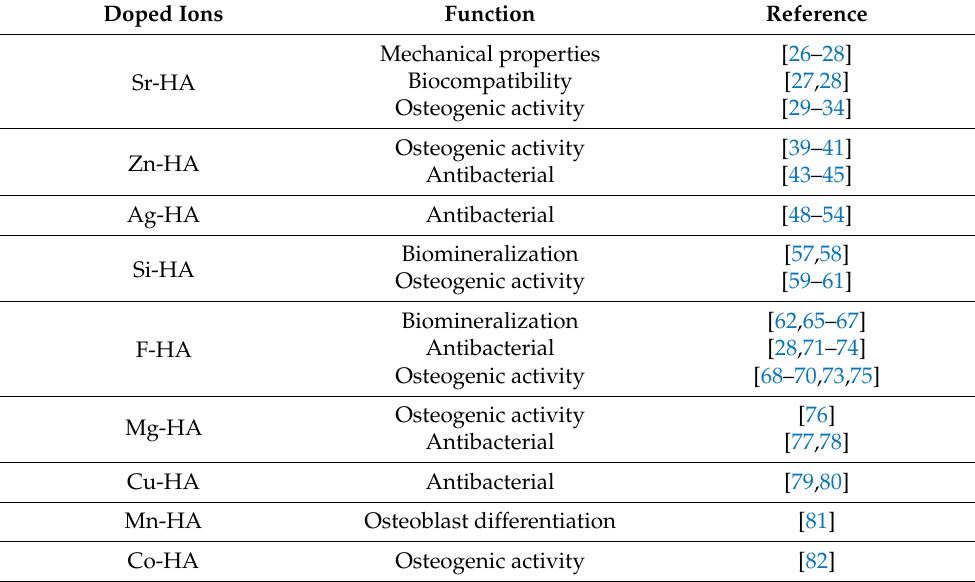
Table 1. Ion doped hydroxyapatite and the enhanced biological function studies. Doped Ions Function Reference